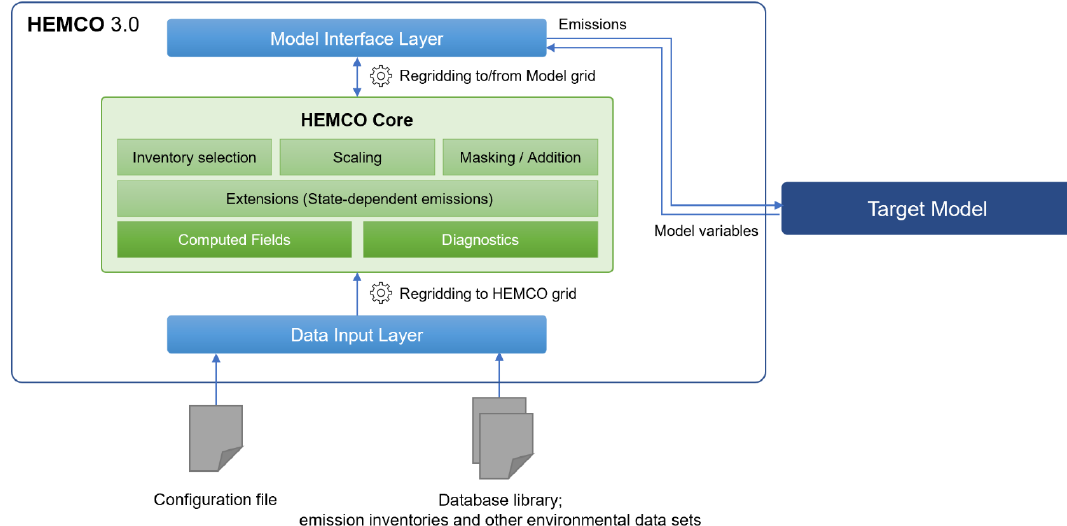
Figure 1. Three-layer architecture of HEMCO 3.0 including the Data Input Layer, the HEMCO Core, and the Model Interface Layer.